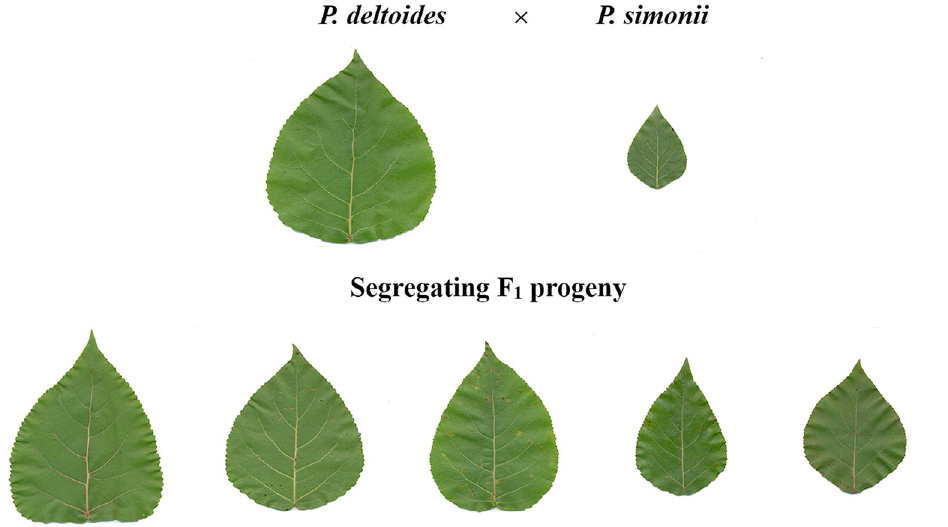
Fig 1. Leaf shape variation among parents and progeny of P . deltoides × P . simonii .